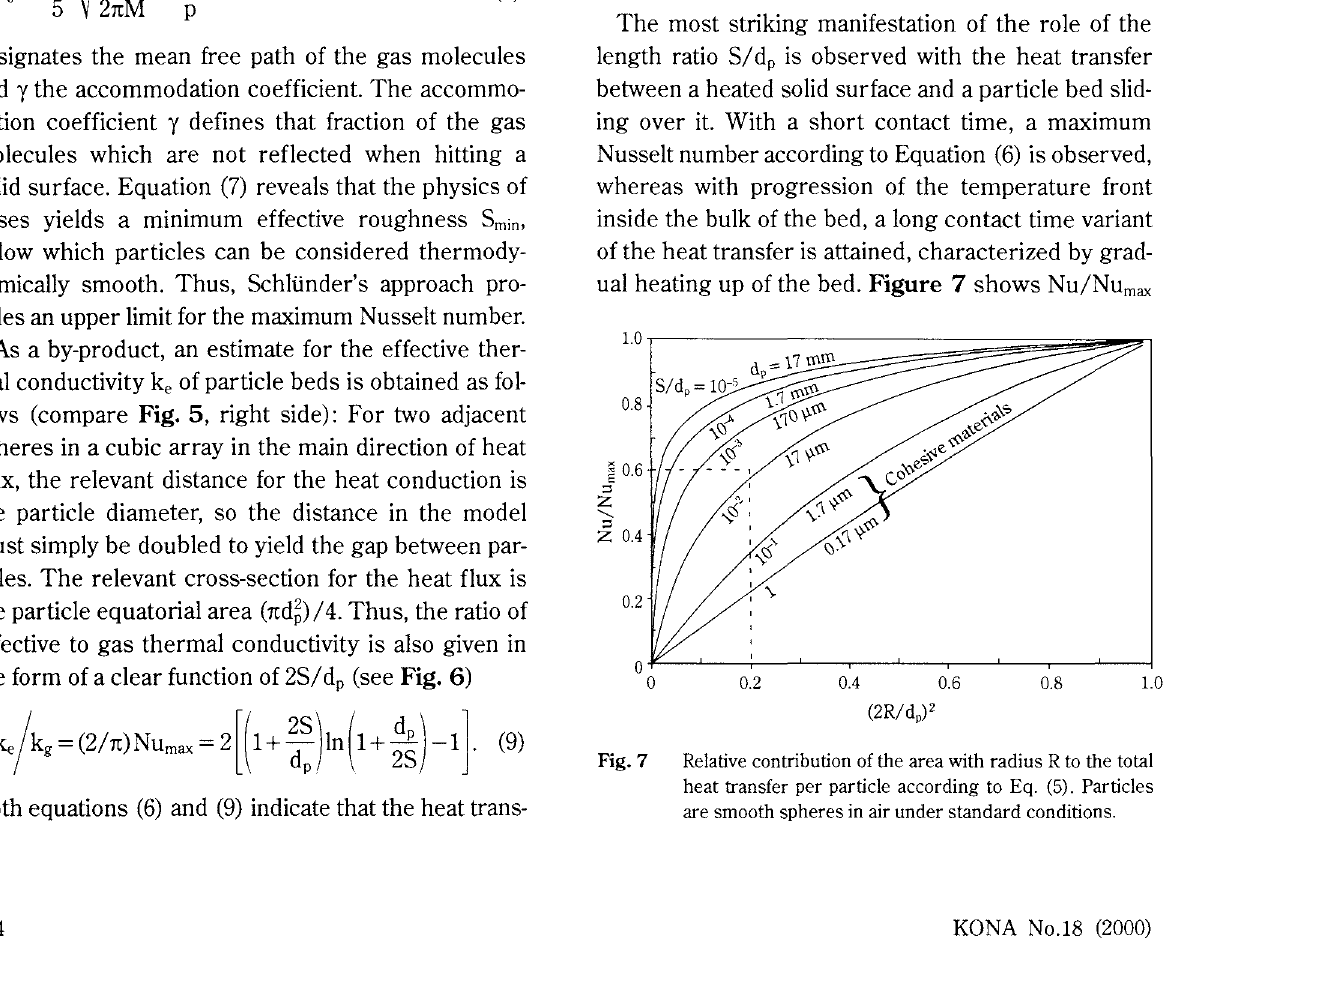
Effective thermal conductivity in particle beds according to Eq. (9). Numerical values of diameter represent ideal spheres in air (nitrogen) at ambient